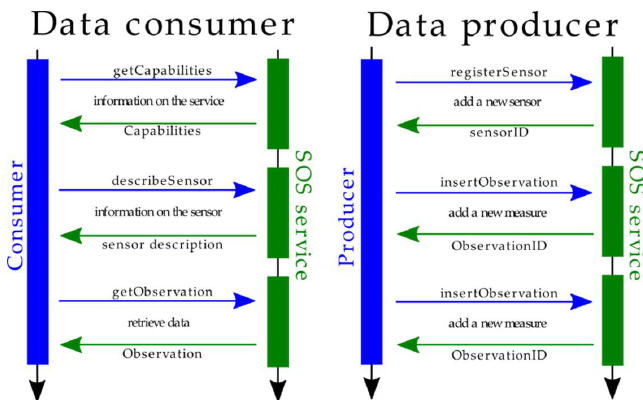
Figure 2. Users of a Sensor Observation Service and workflow of interactions with the server for information access.